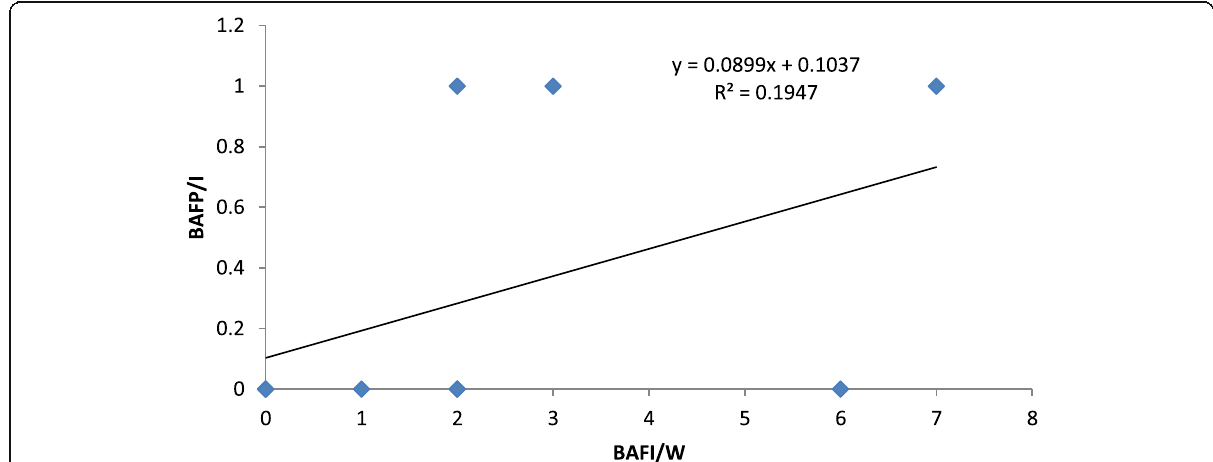
Fig. 2 Linear regression of bioaccumulation factor of BTEX in parasite relative to intestine against bioaccumulation in intestine relative to